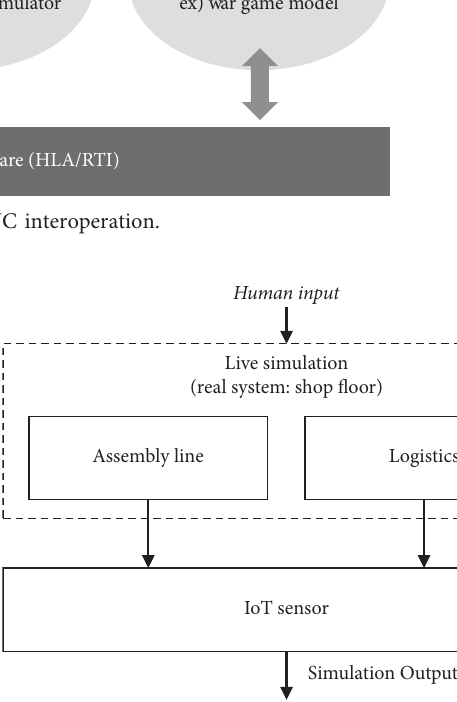
Figure 2: Concept of live simulation in smart manufacturing.